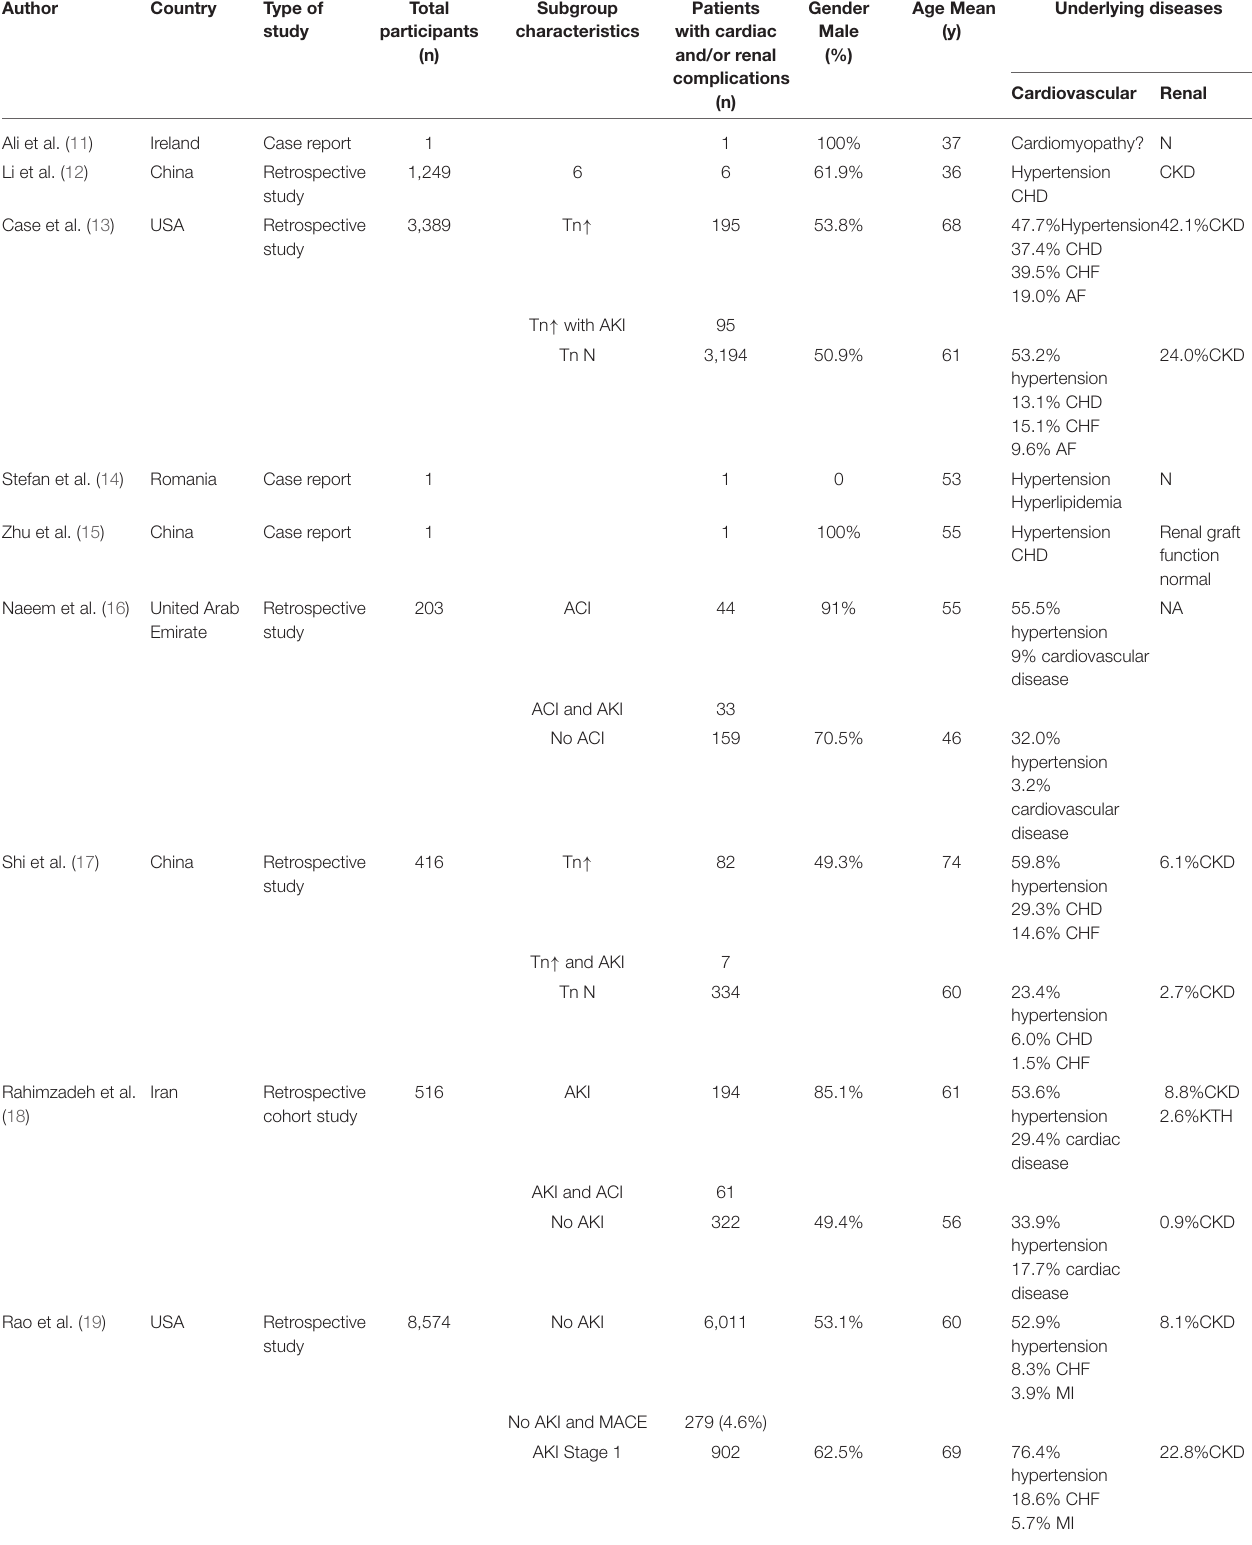
TABLE 1 | Characteristics of the included